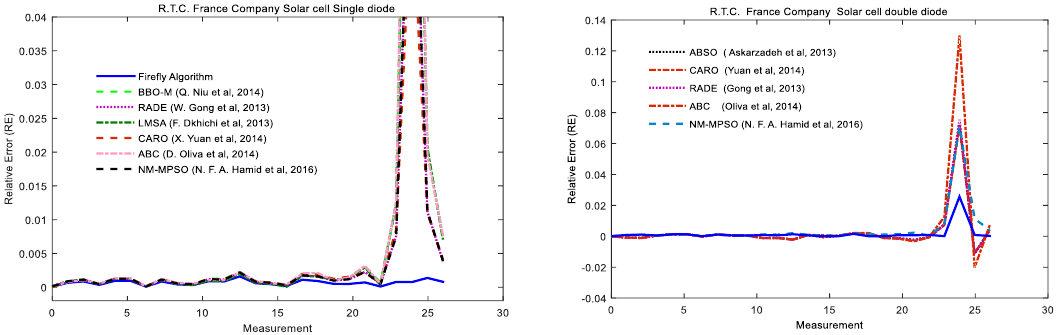
Figure 6. Relative Error (RE) plots for single and double diode for Mono-crystalline silicon solar cell, RTC France Company.